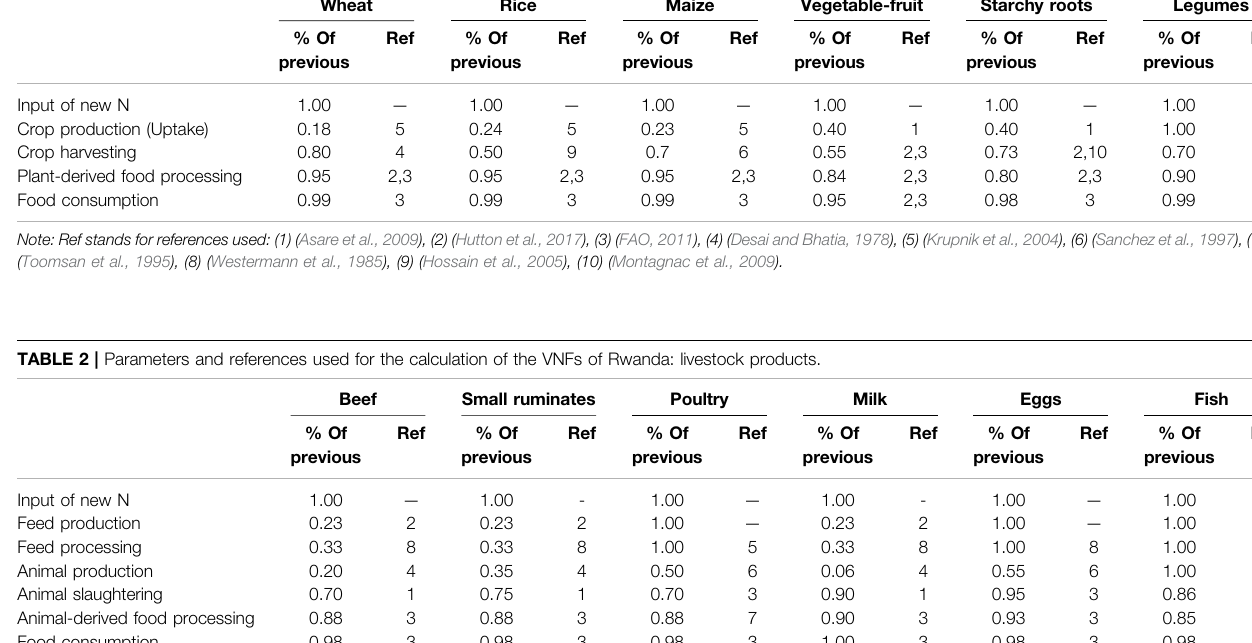
TABLE 1 | Parameters and references used for the calculation of the VNFs of Rwanda: crop products. Wheat